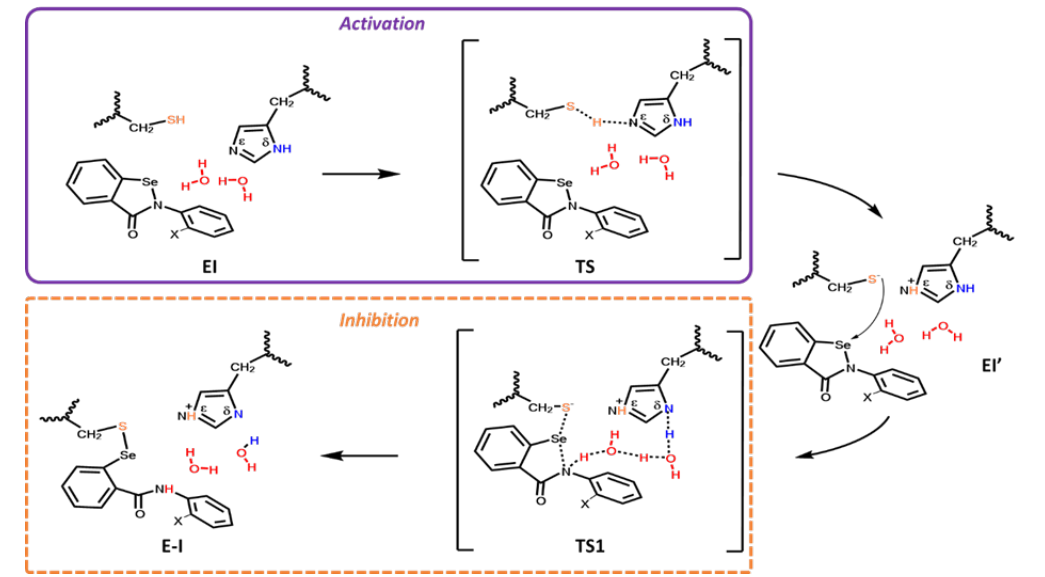
Scheme 3. Proposed mechanism for the covalent inhibition of M pro SARS-CoV-2 for HID by EBS in two phases: activation (in violet) and inhibition through covalent bond formation (in dashed orange). X indicates H for EBS and OH for EBS-OH.